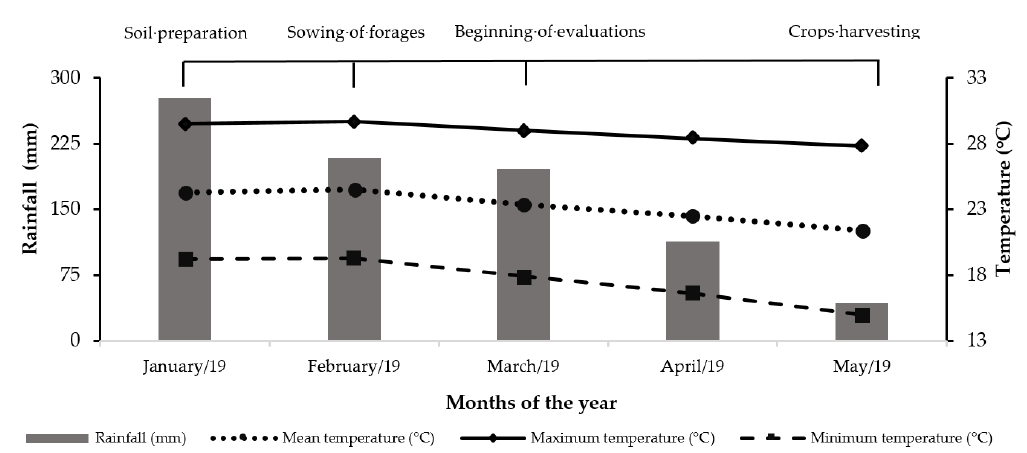
Figure 1. Precipitation values (mm), maximum temperature (°C), minimum temperature (°C), and average temperature (°C) in Rio Verde, Goias, Brazil, from January to May 2019.